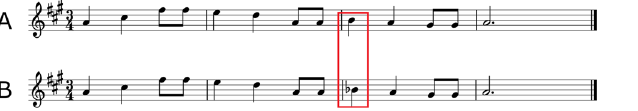
Figure 1. Example of ( A ) an in-key melody and ( B ) the same melody, altered to be out-of-key. The target tone in both melodies is marked in red. Note that performance feedback was presented after the participant’s response, rather than during the